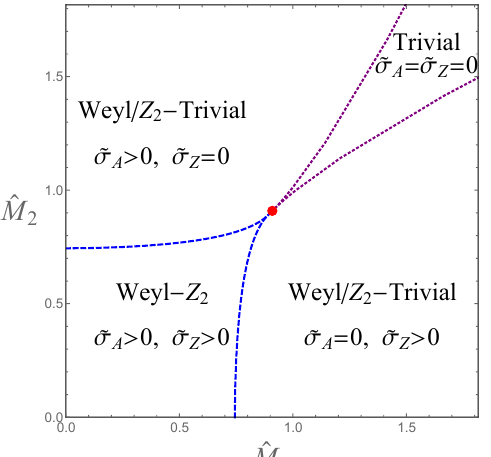
Figure 6. The holographic phase diagram at c/b = 1 . ˜ σ A = σ AHE and ˜ σ Z = σ Z 2 AHE . The red point 8 αb 8 βc corresponds to the critical phase, at which both ˜ σ A and ˜ σ Z are zero. The blue dashed lines and the purple dotted lines are two critical phase transition lines with one critical Dirac node and one pair of nodes or gapped bands. The up-left and bottom-right parts of the phase diagram correspond to the Weyl/ Z 2 -Trivial phase where ˜ σ Z = 0 while ˜ σ A 6 = 0 or ˜ σ Z 6 = 0 while ˜ σ A = 0 . The right-up part in the phase diagram corresponds to the phase where both the Weyl-Z 2 nodes vanish and become trivial, i.e. the Trivial-Trivial phase. In this case, both of the two anomalous